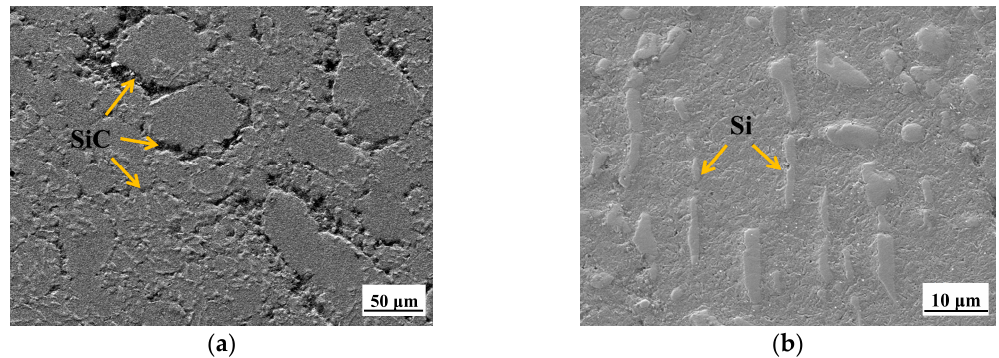
Figure 5. SEM images of the PM-8p-ECAP composite: ( a ) low and ( b ) high magnification.